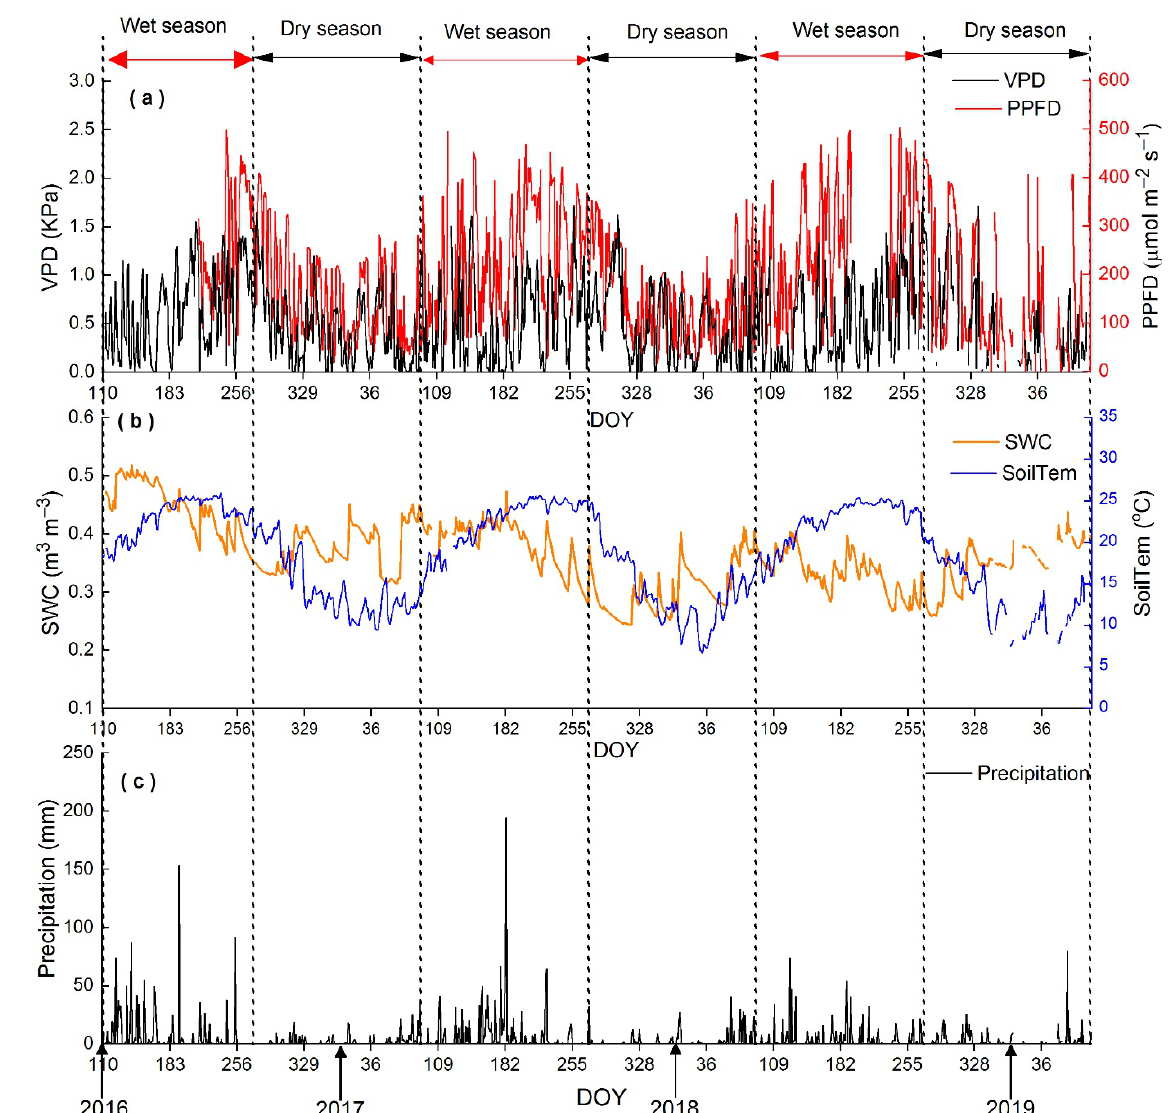
Figure 1. Daily averaged vapor pressure deficit (VPD, kPa), photosynthetic photon flux density (PPFD, μmol m −2 s −1 ) ( a ); soil water content (SWC, m 3 ·m 3 ), and soil temperature (SoilTem, °C) ( b ); total daily precipitation (mm) ( c ) from 17 May 2016 to 31 March 2019. Missing data were due to instrument or power failure.